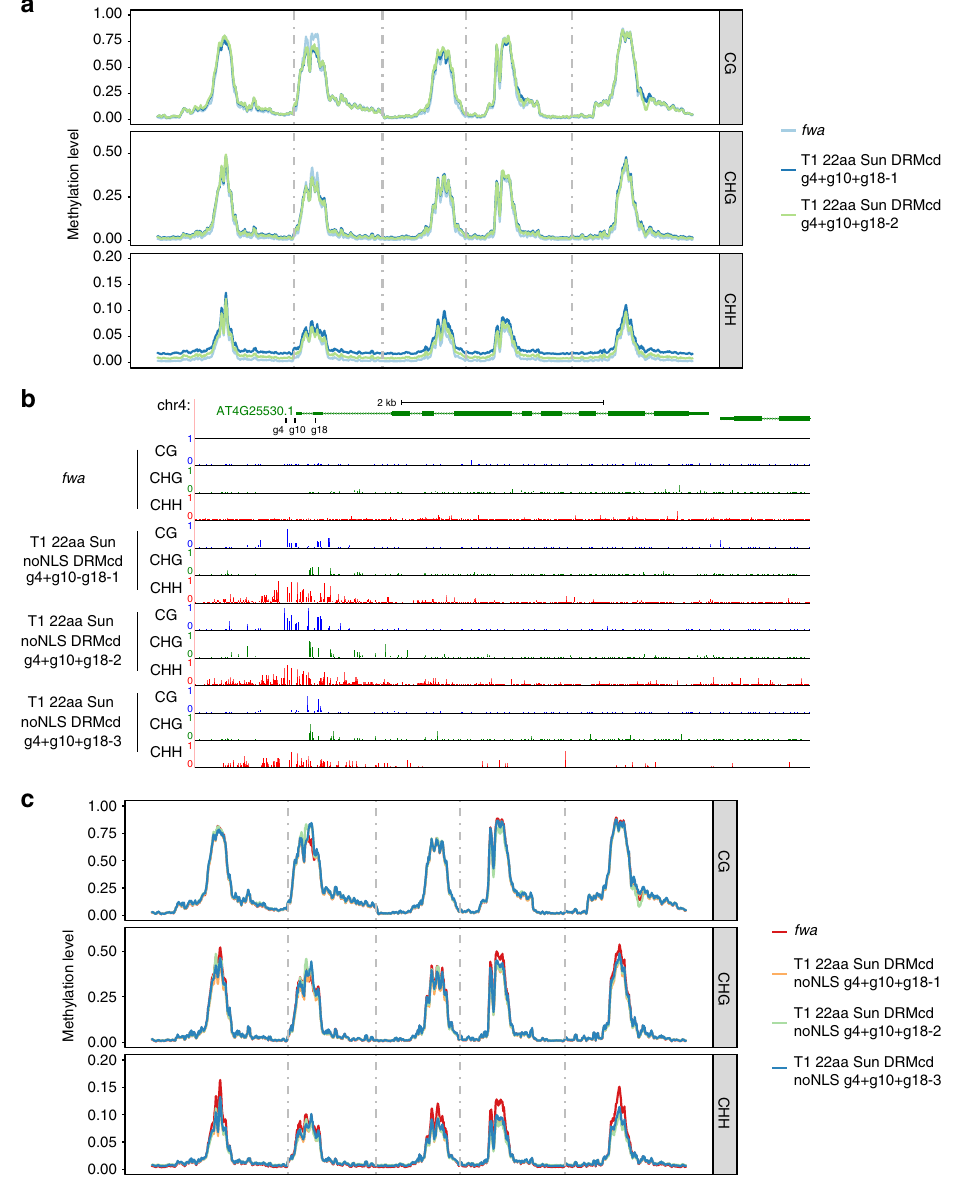
Fig. 4 Pro fi ling the genome-wide effects of scFv-sfGFP-NtDRMcd activity. a Chromosome-wide metaplots of CG, CHG, and CHH methylation levels in fwa , and 2 independent T1 lines of 22aa SunTag NtDRMcd g4 + g10 + g18. Dashed vertical lines depict the boundaries of chromosomes 1 – 5. b WGBS tracks for all 3 sequence contexts at the FWA promoter for fwa and 3 independent T1 lines of 22aa SunTag NtDRMcd noNLS g4 + g10 + g18. Black bars indicate the positions of the 3 gRNAs. c Chromosome-wide metaplots of CG, CHG, and CHH methylation levels in fwa and 3 independent T1 lines of 22aa SunTag NtDRMcd noNLS g4 + g10 +